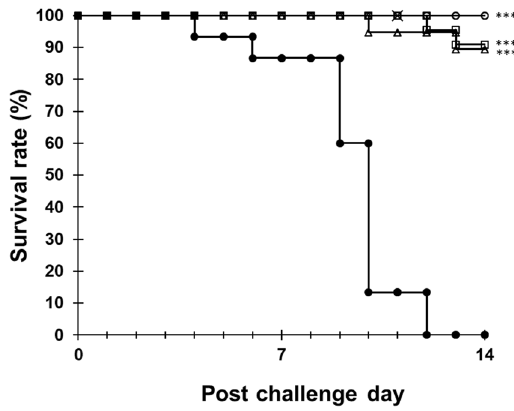
Figure 5. Survival curves of L. vannamei after immersion with the Vibrio penaedia IAYKG13-1 strain (input dose: 3.8 × 10 5 cells/L). Control diet group (filled circle), 0.0125 μ g/g silkrose-BM diet group (open square), 0.250 μ g/g silkrose-BM diet group (open triangle) and 5 μ g/g silkrose-BM diet group (open circle). The cross indicates drop-out cases due to accidental death. Asterisks indicate statistically significant differences compared with the control group by log rank test with Bonferroni correction ( p < 0.05). * p < 0.01, ** p < 0.001, *** p <